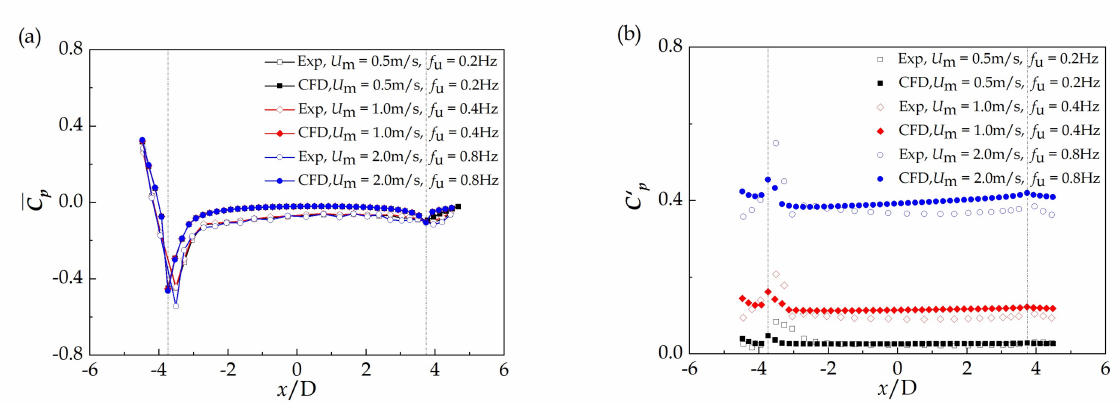
Figure 4. Comparison of numerical and experimental results in sinusoidal flow: ( a ) mean pressure coefficients (top side); ( b ) fluctuating pressure coefficients (top